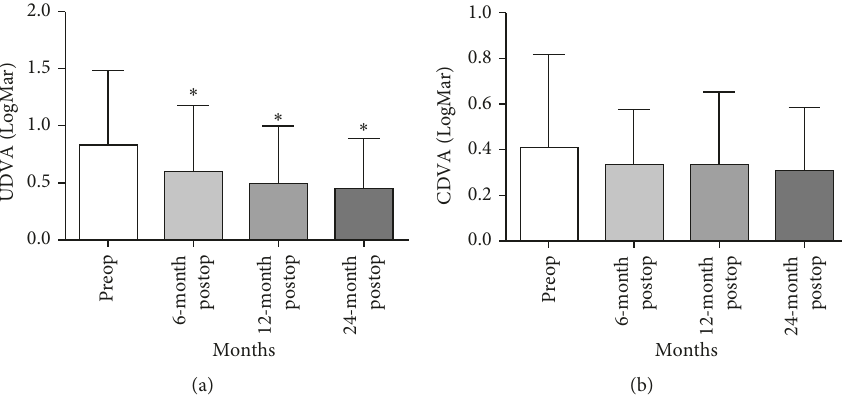
Figure 2: Preoperative and postoperative visual outcomes. (a) Phototherapeutic keratectomy combined with PRK and CXL significantly improved UDVA ( P < 0 . 05) at 6, 12, and 24 months follow-up. (b) Phototherapeutic keratectomy combined with PRK and CXL did not significantly improve CDVA at 6, 12, and 24 months follow-up. ∗ Preoperatively vs postoperatively 6, 12, and 24 months P < 0 . 05.